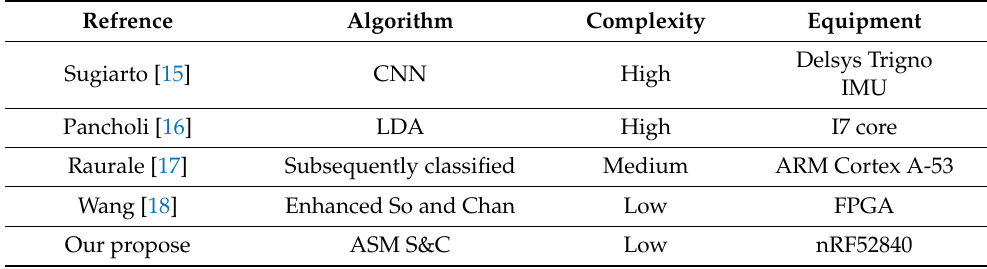
Table 1. Comparison of Recent Studies on Physiological Signal Detection Systems.